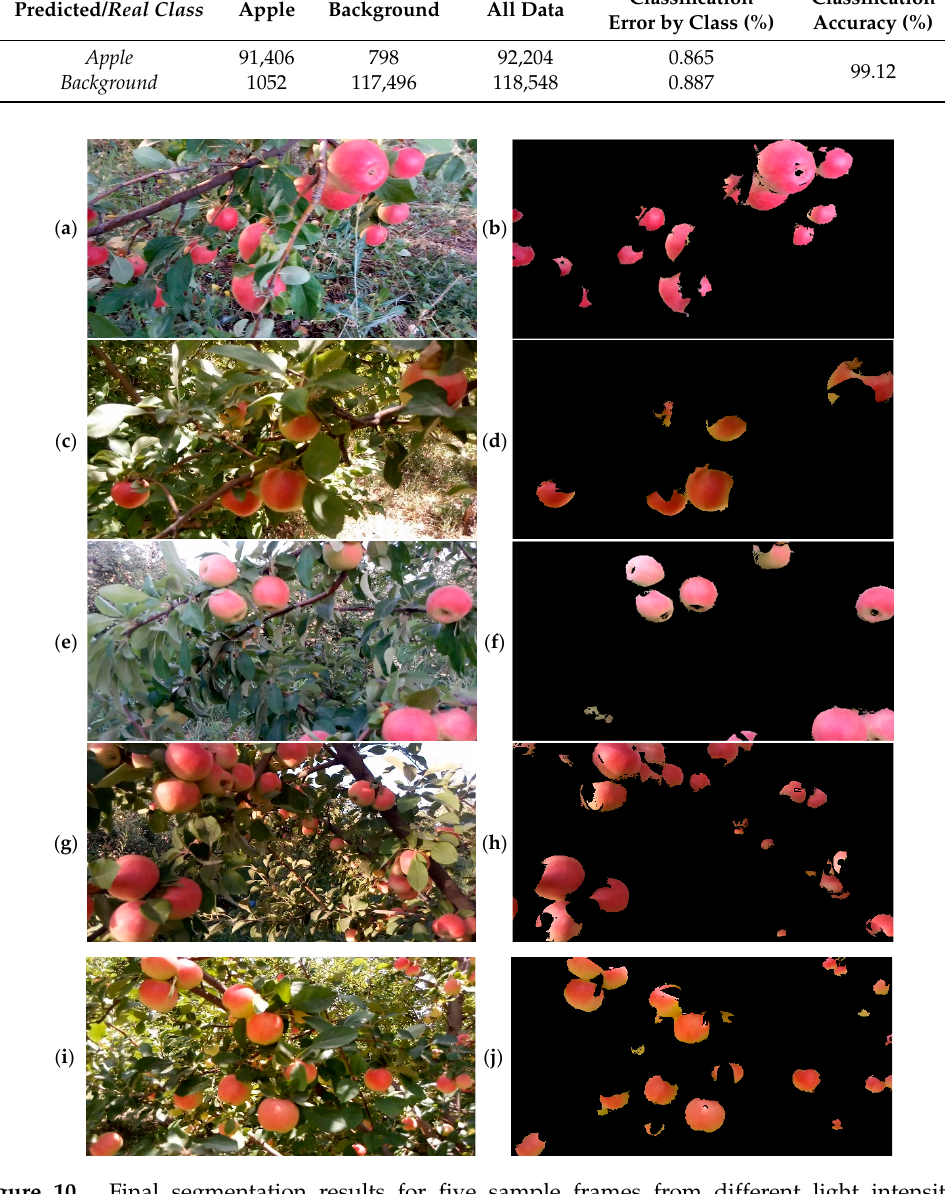
Figure 10. Final segmentation results for five sample frames from different light intensities. ( a , c , e , g , i ) Original color images. ( b , d , f , h , j ) Corresponding segmented images, with background in black.